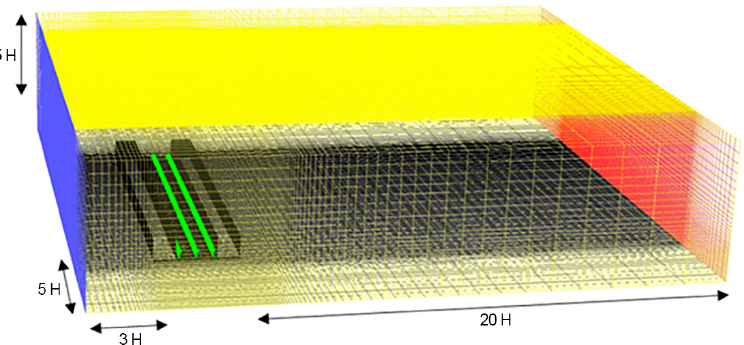
Figure 6. Mesh design of the computational fluid dynamics (CFD) simulation model used in this study (H indicates the height of a building).